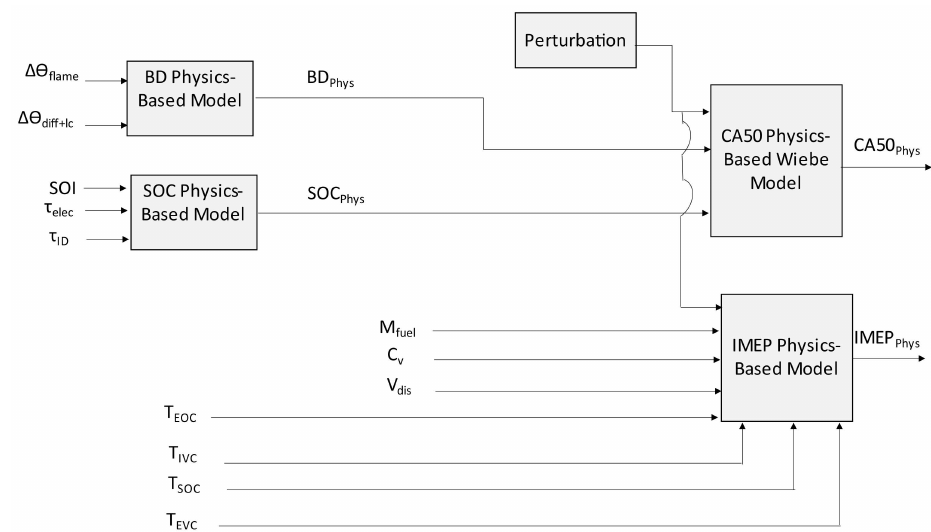
Figure 11. CA50 and IMEP physics-based model framework.